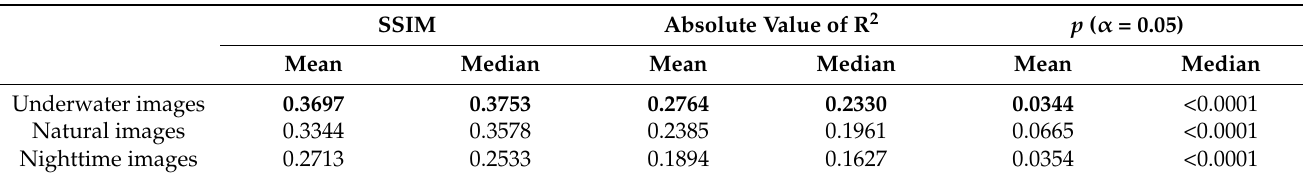
Table 1. Similarity between images and THz spectrum.